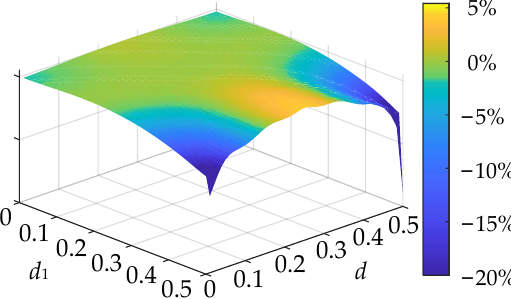
Figure 5. Showing 3D plots of Y P varying with d 1 and d .